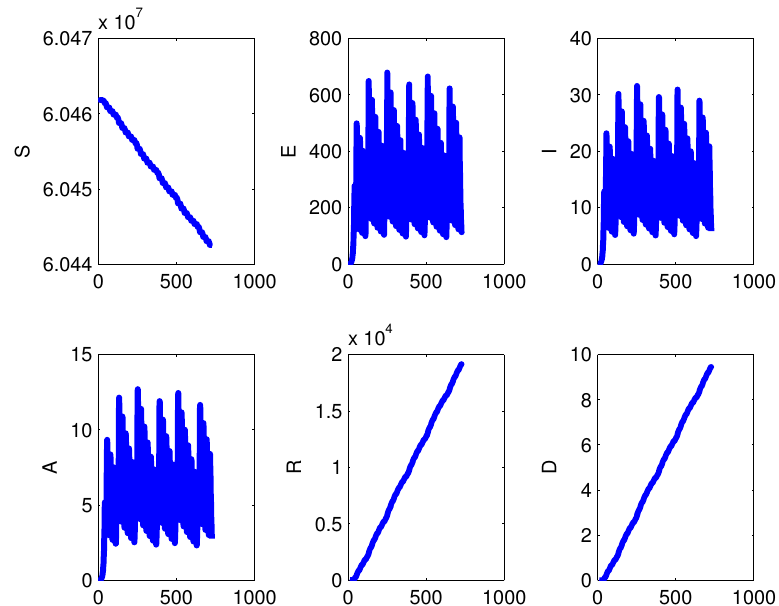
Figure 17. The total populations with the intermittent lock-down policy, implemented from time 1. Here the population is checked every week. If the number of infected is above a small threshold (here taken to be 10) the reduced contact rate β I = 10 − 10 is resumed for a week. The simulation runs over two years timespan for the simplified model with no demographics (1) where we take Λ = 0, d p = 0. Left to right and top to bottom, the subpopulations are: S , E , I , A , R and D , the disease-related deceased class.